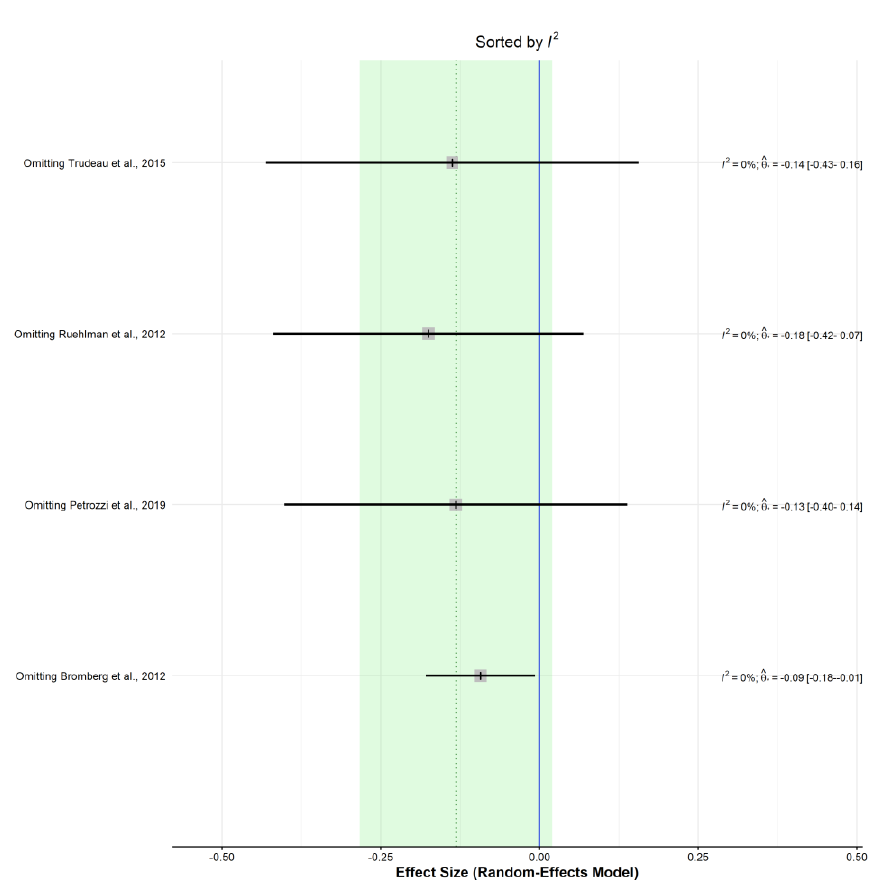
Figure A18. Leave-one-out figure of all the studies.